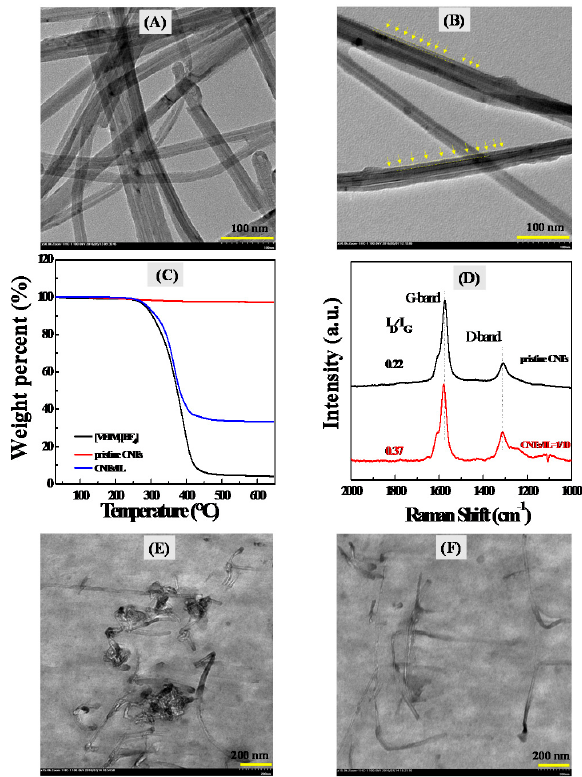
Figure 1. ( A ) Transmission electron microscopy (TEM) image of pristine carbon nanotubes (CNTs) dispersed in the water; ( B ) TEM image of ionic liquids (ILs) coated CNTs dispersed in the water; ( C ) Thermogravimetric analysis (TGA) curves of pristine CNTs, pure ILs and ILs modified CNTs, respectively; ( D ) Raman spectra of pristine CNTs and IL coated CNTs (i.e. CNTs/IL=1/10); ( E ) TEM image of PVDF/CNTs (100/1) composite; ( F ) TEM image of PVDF/ IL-CNTs (100/10-1) nanocomposites.